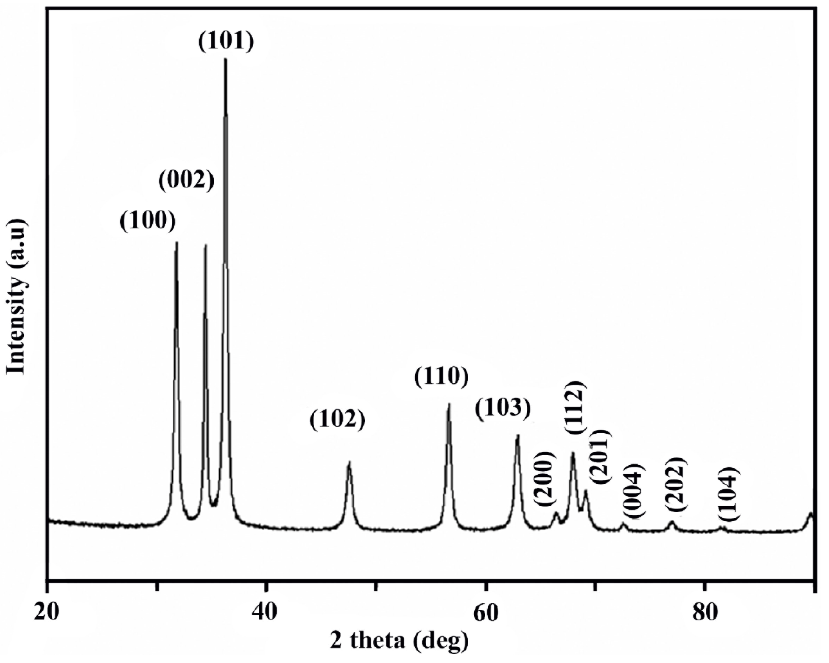
Figure 3. XRD pattern of N-ZnO Ps.